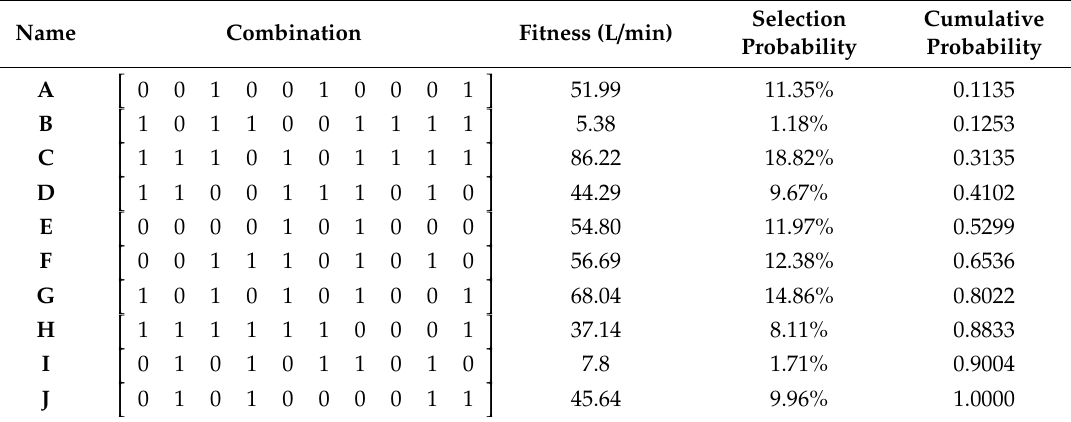
Table 1. The table below shows ten di ff erent individuals (A–J) in a population along with the individuals’ fitnesses as measured in liters per minute and the probability that the individual will be selected for